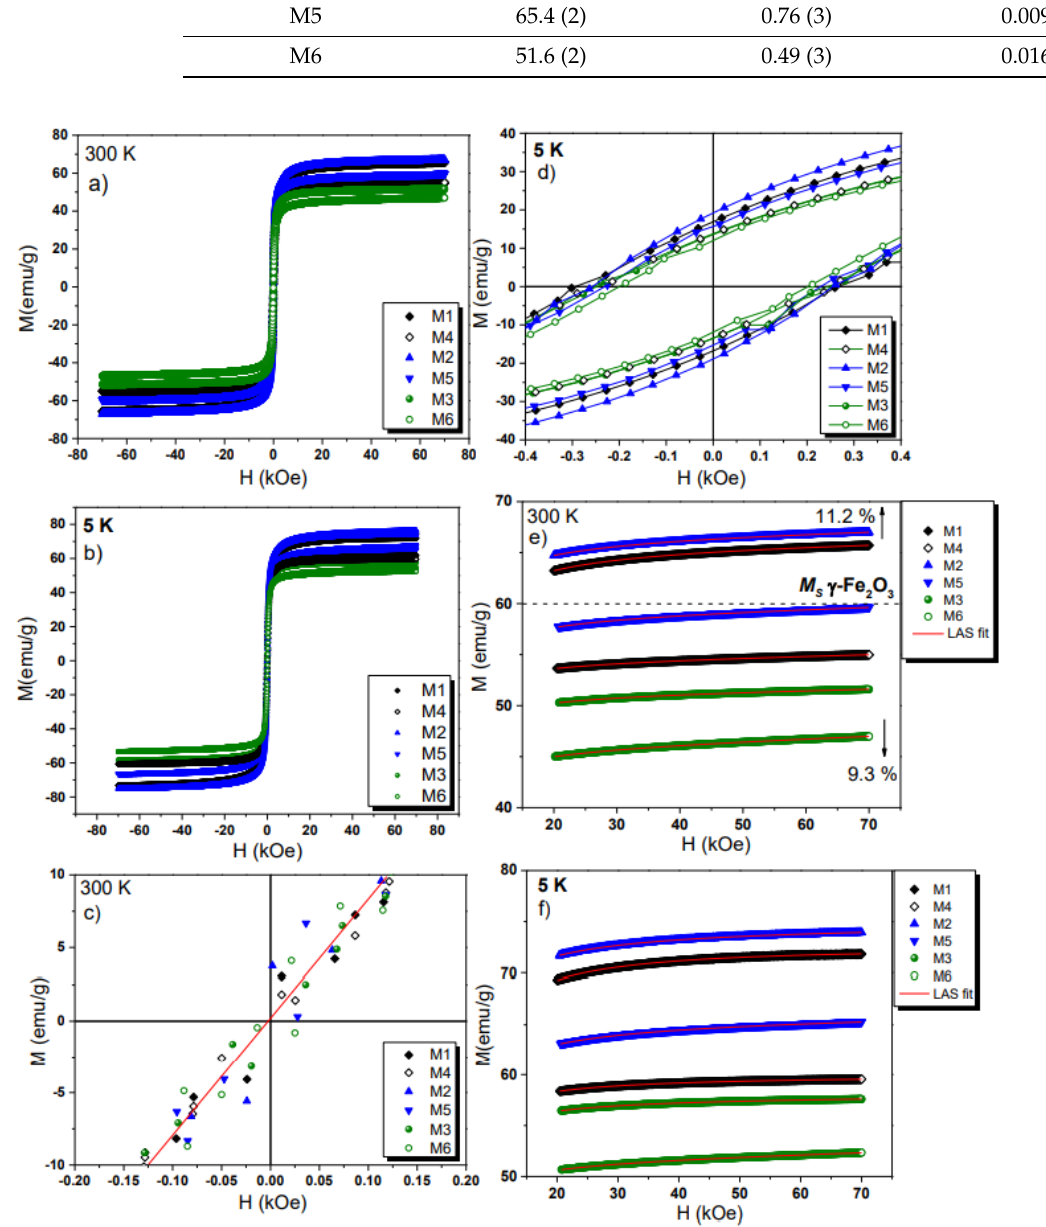
Figure 10. M(H) loops recorded at 300 K ( a ) and 5 K ( b ). Zoomed field section at 300 K ( c ) and 5 K ( d ). LAS fit at 300 K ( e ) and 5 K ( f ) for the M series samples.